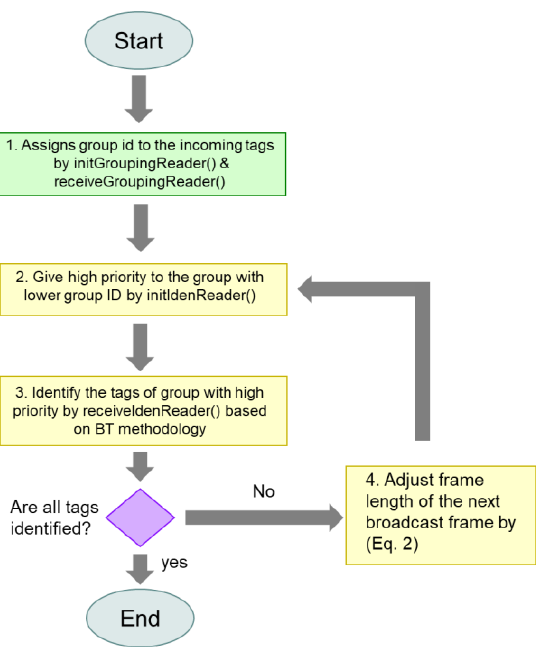
Figure 7. Flowchart of MABT.